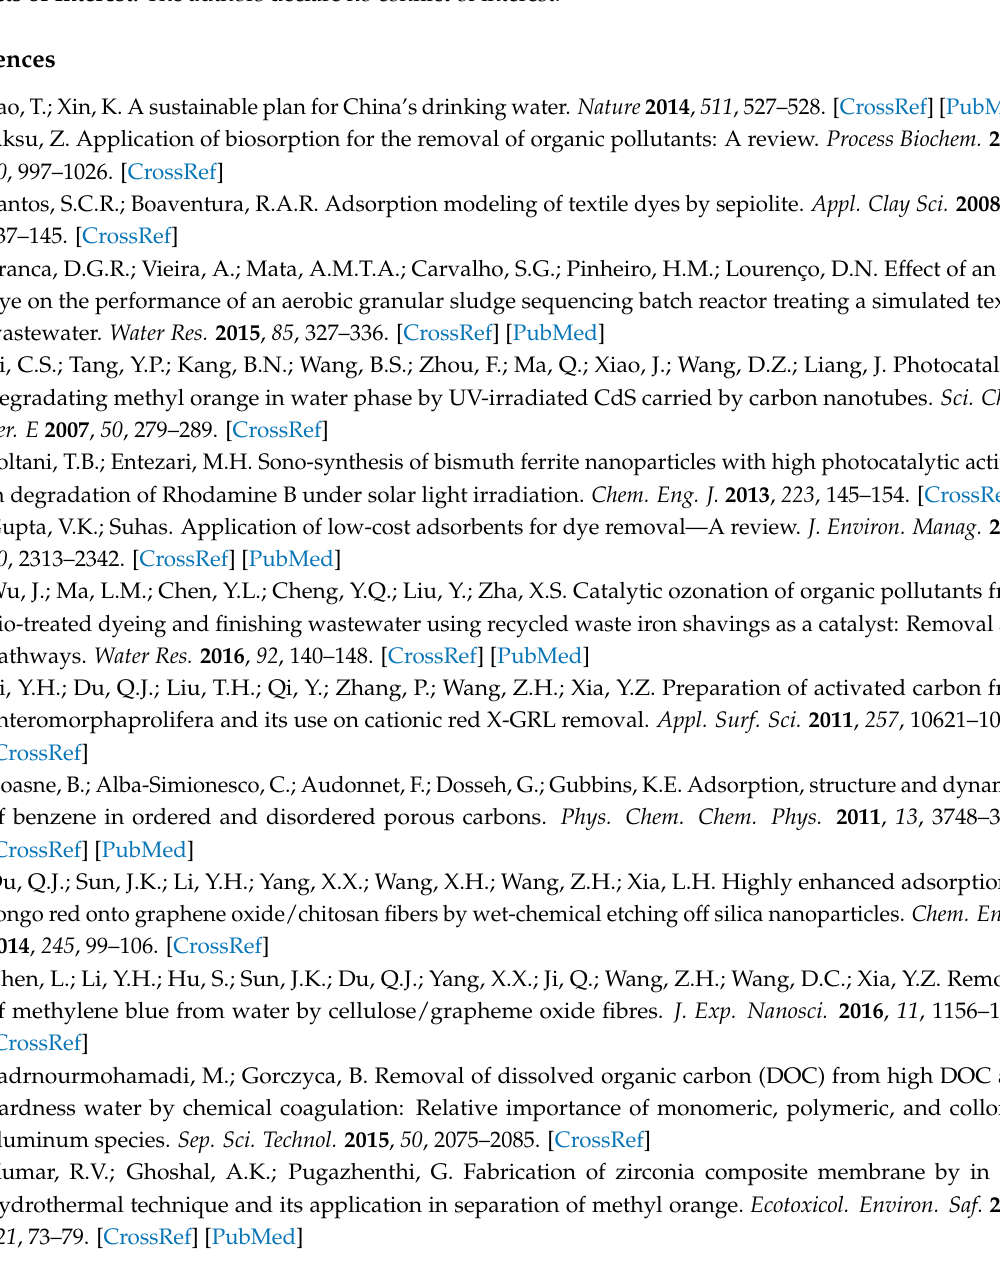
Figure S1: The Raman spectra of the three